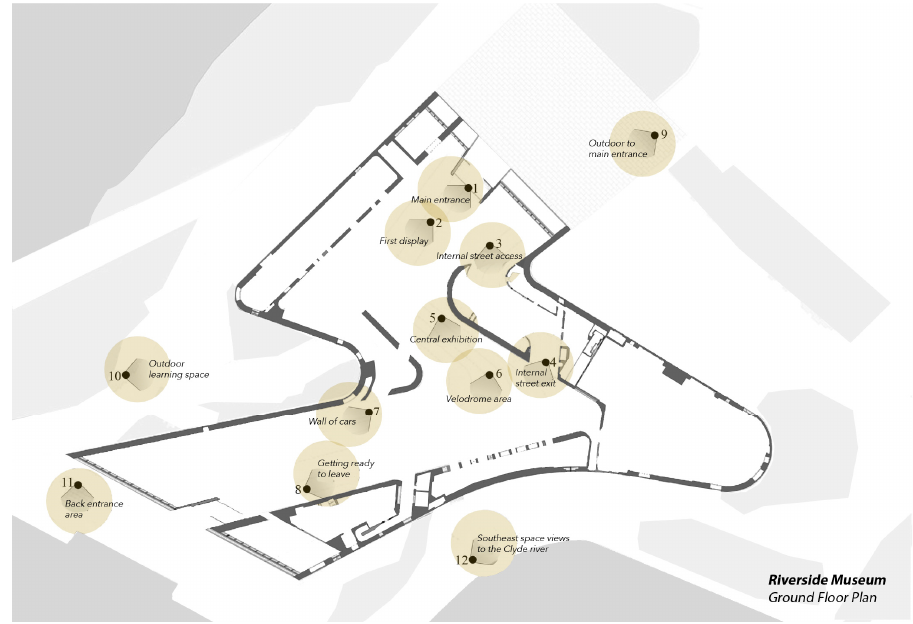
Figure 4. RSM Floor Plan showing the 12 locations/spots examined in the emotional experience survey. (Floorplan by L. MacLean based on figure by ZHA published in ArchDaily) Table 2. Example of users’ emotional experience record sheet.